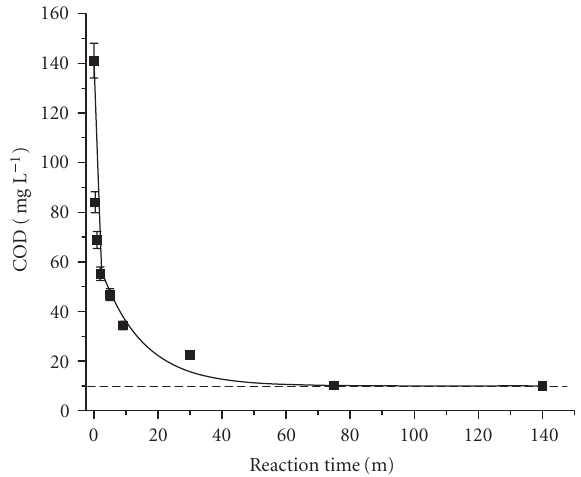
Figure 8: COD abatement of a solution of 0 . 289 mmol L − 1 atrazine versus reaction time under solar irradiation: ( (cid:2) ) with 10 mmol L − 1 K2S2O and 200 mg L − 1 TiO 2 ; ( (cid:3) ) with 10mmol L − 1 K2S2O8. The best fit (—) of the experimental data was for an exponential decay second-order equation. The dashed line represents the determina- tion limit of COD